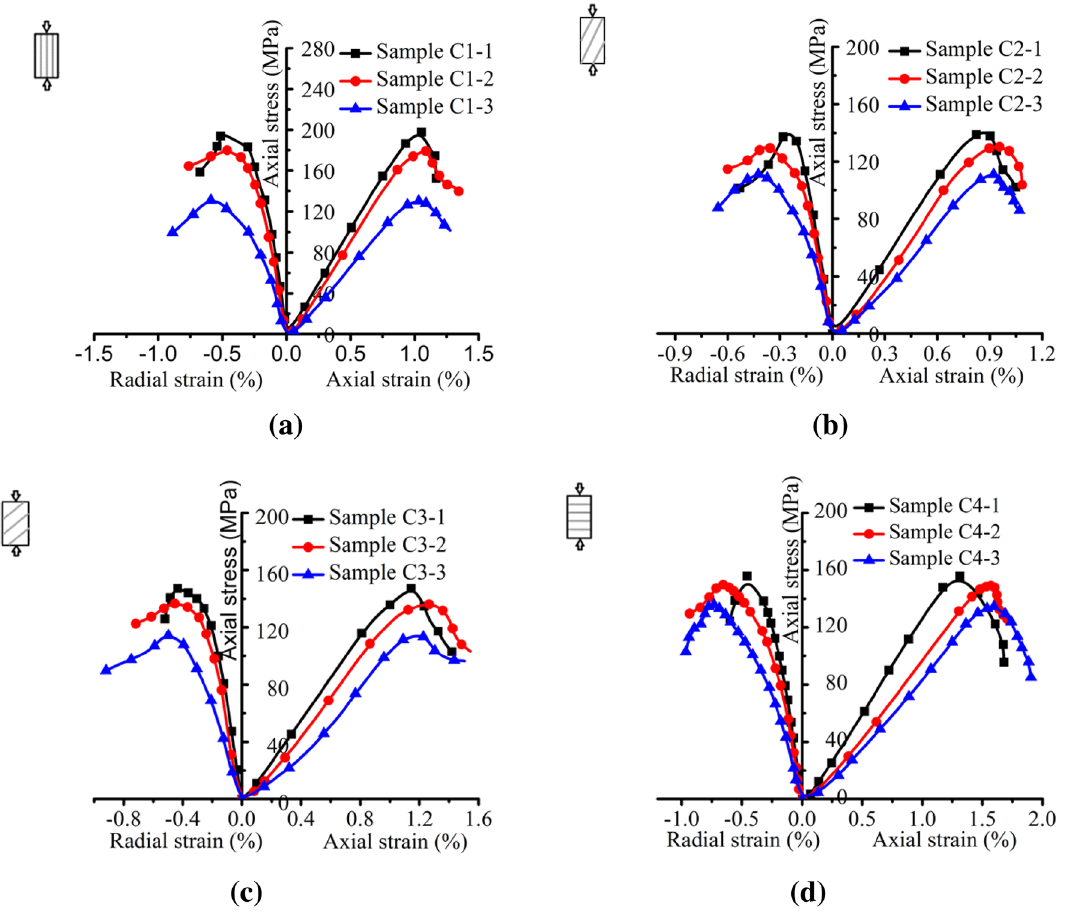
Fig. 6 Stress–strain curves of different bedding shales before and after LN